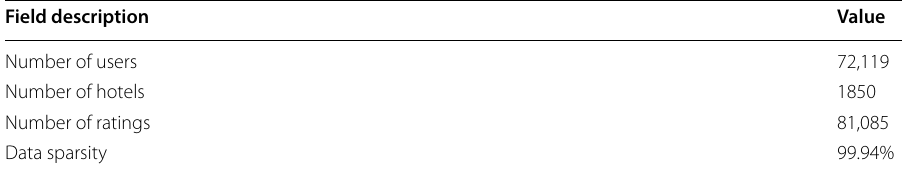
Table 1 TripAdvisor dataset statistics